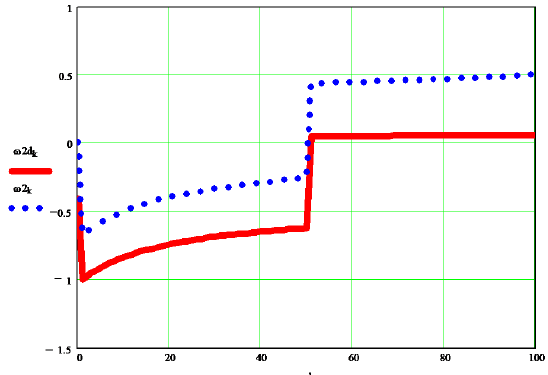
Figure 12. The differences between angular dynamic velocity w 2 d and the angular kinematic velocity w 2.